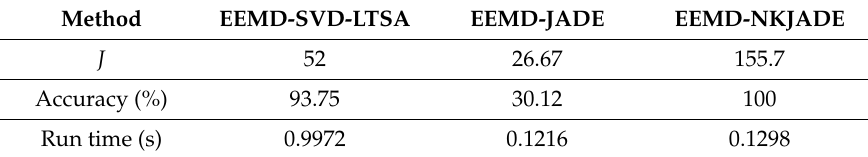
Figure 9. Scatter plot of feature extraction from multi-sensor data. ( a ) EEMD-SVD-LTSA; ( b ) EEMD-JADE; ( c ) EEMD-NKJADE. Table 5. The separability J , running time, and accuracy using di ff erent sensor fusion methods.